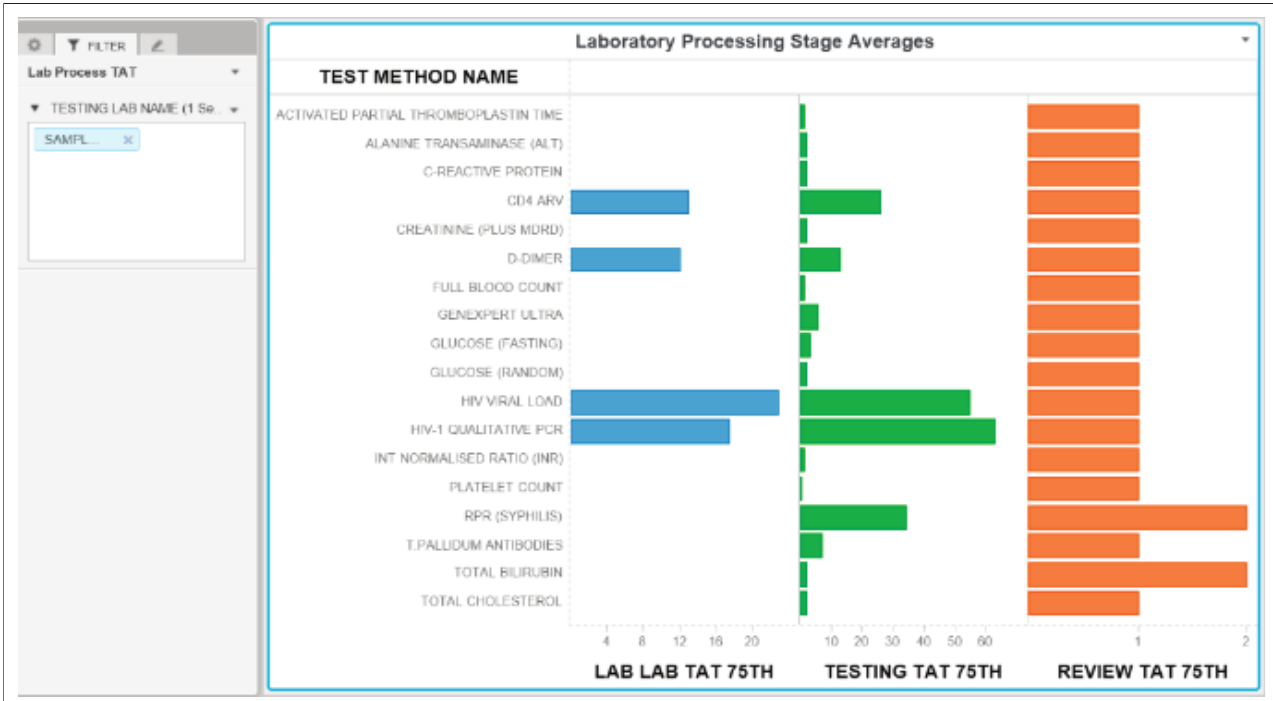
FIGURE 4: MicroStrategy Desktop dashboard bar chart used to report the component turn-around time data for an example site’s for the week 2–8 September 2018, South Africa. The components reported are LAB-LAB (inter-laboratory referral time), TESTING (time from registration to testing) and REVIEW (time from testing to review) turn-around time